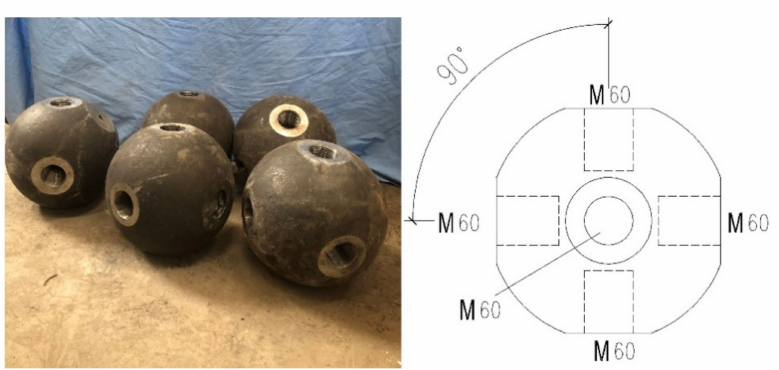
Figure 3. The bolted sphere used